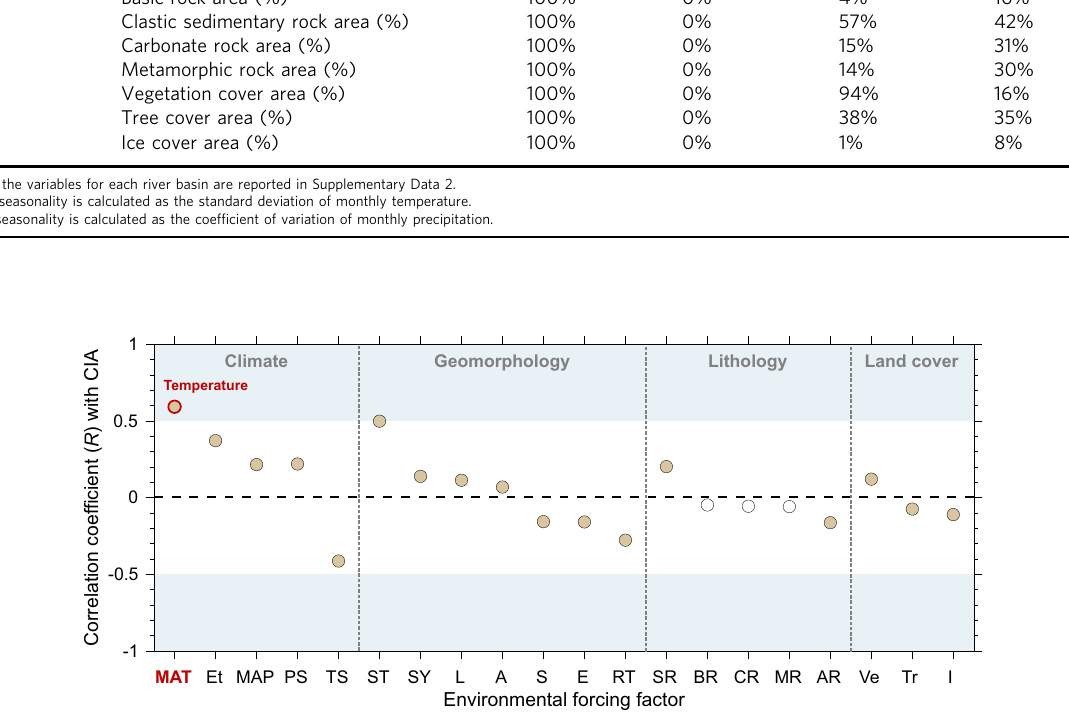
Fig. 3 Correlation coef fi cients ( R ) between each environmental forcing factor ( n = 20) and CIA. Correlations with p value of >0.001 are shown as open symbols. The order of forcing factors in each category is sorted by correlation coef fi cient with CIA. Negative values mean a negative correlation. Most of | R | are lower than 0.5, indicating a subordinate control of these factors on weathering intensity over a global scale. Mean annual temperature (MAT) is the only factor with | R | of >0.5. The correlation coef fi cients ( R ) with WIP are provided in Supplementary Fig. 2. Climatic metric: MAT-mean annual temperature ( o C), Et-actual evapotranspiration (m/yr), MAP-mean annual precipitation (m/yr), PS-precipitation seasonality (coef fi cient of variation, %), TS-temperature seasonality (standard deviation, °C); geomorphic metric: ST-upland hillslope soil thickness (m), SY-modeled sediment yield (t/km 2 /yr) using BQART model 29 , L- fl ow length (km), A-drainage area (km 2 ), S-mean local slope ( o ), E-mean elevation (m), RT-upland hillslope regolith thickness (m); lithological metric: SR-clastic sedimentary rock area (%), BR-basic rock area (%), CR-carbonate rock area (%), MR-metamorphic rock area (%), AR- acidic-intermediate rock area (%); land cover metric: Ve-vegetation cover area (%), Tr-tree cover area (%), I-ice and snow cover area